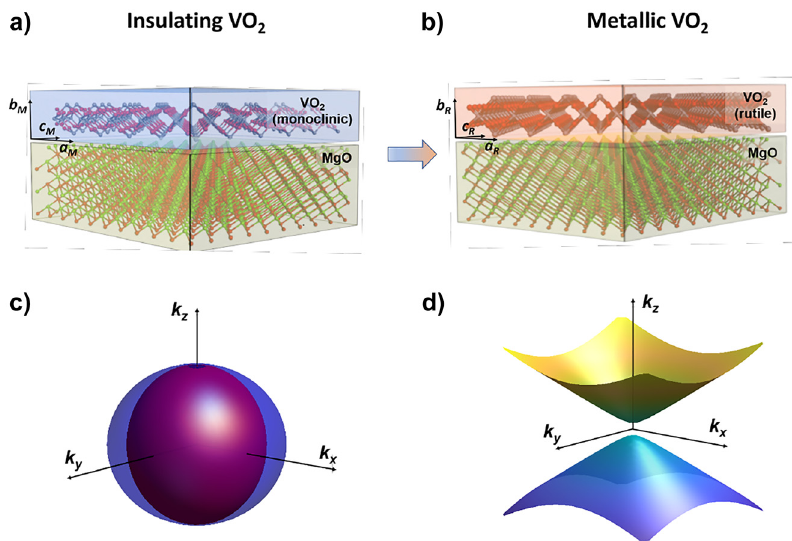
Figure1: Structuralandopticalanisotropyin thin VO 2